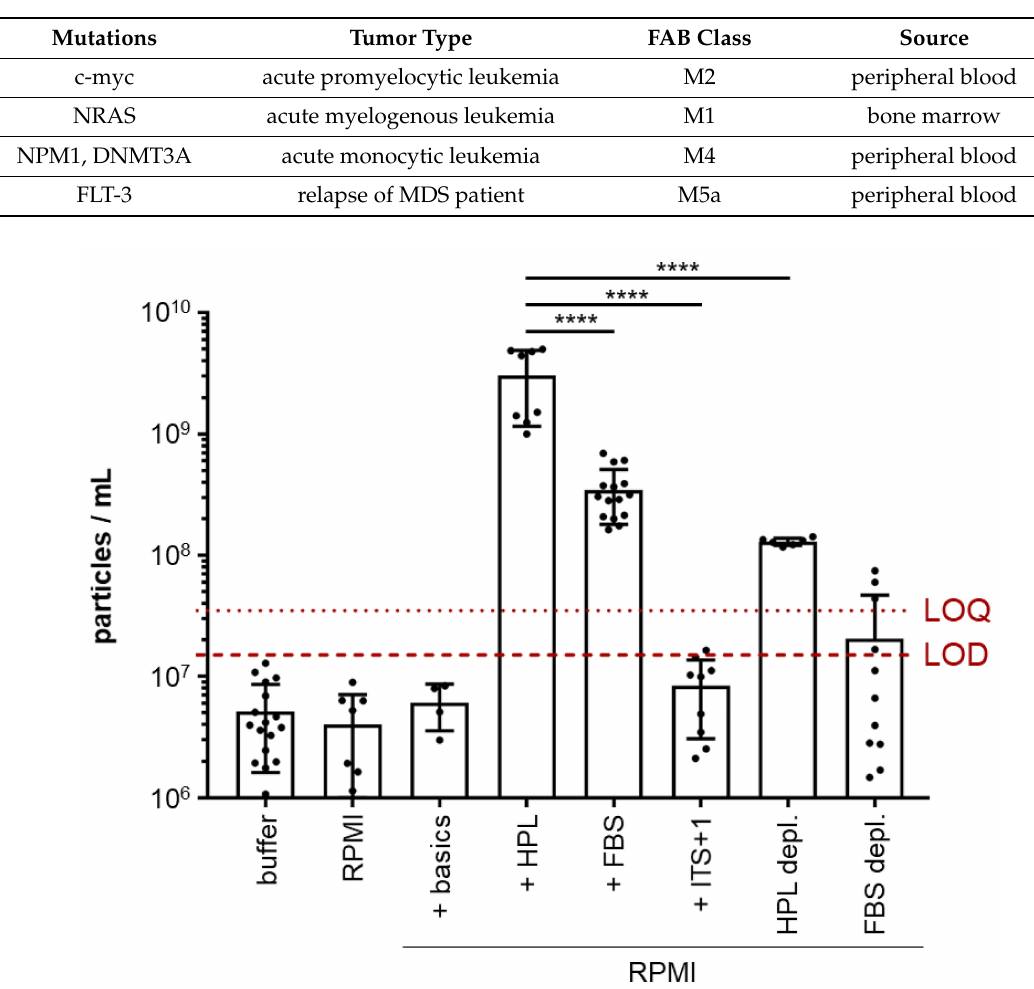
Figure A1. Particle content varies among common culture media for cell-derived EV analysis.